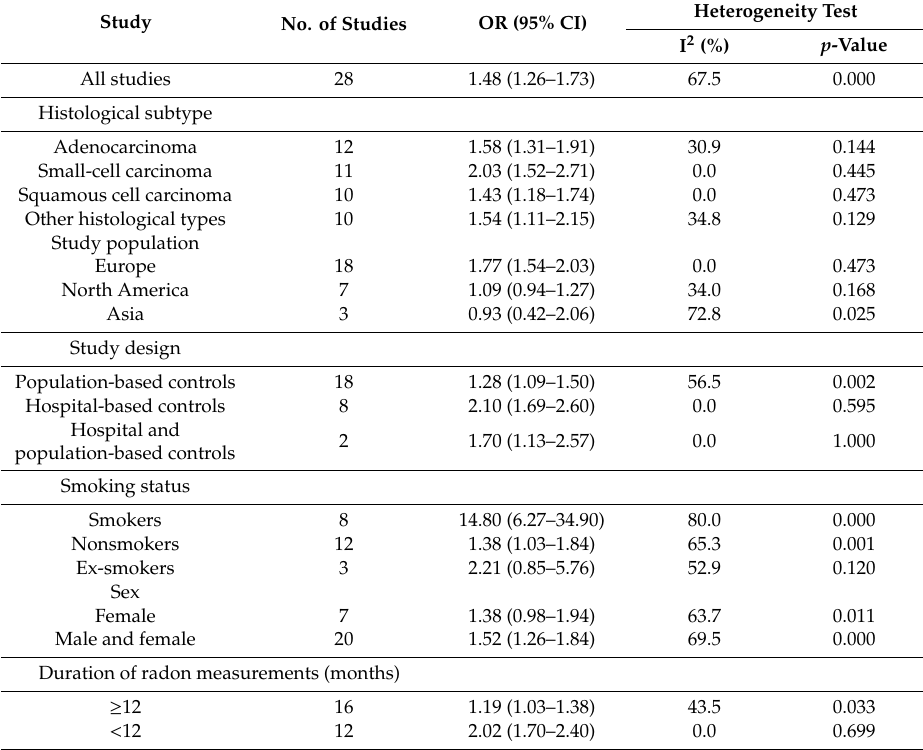
Table 2. Summary risk estimates for residential radon exposure (highest versus non / lowest) and lung